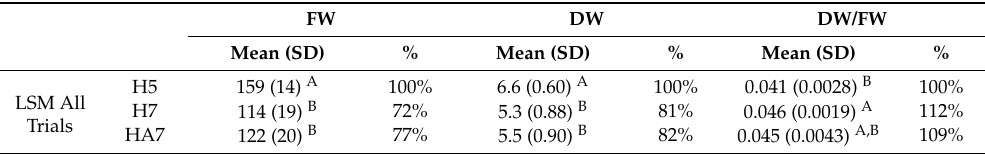
Table 5. Least squares means (LSM) for shoot mean, standard deviation (SD), and percentage comparison to H5 response for fresh weight (FW, g), dry weight (DW, g), and dry weight to fresh weight ratio (DW/FW, g/g) with multi-model significance. Differing superscript letters within response variables (columns) denote significance at α = 0.05.